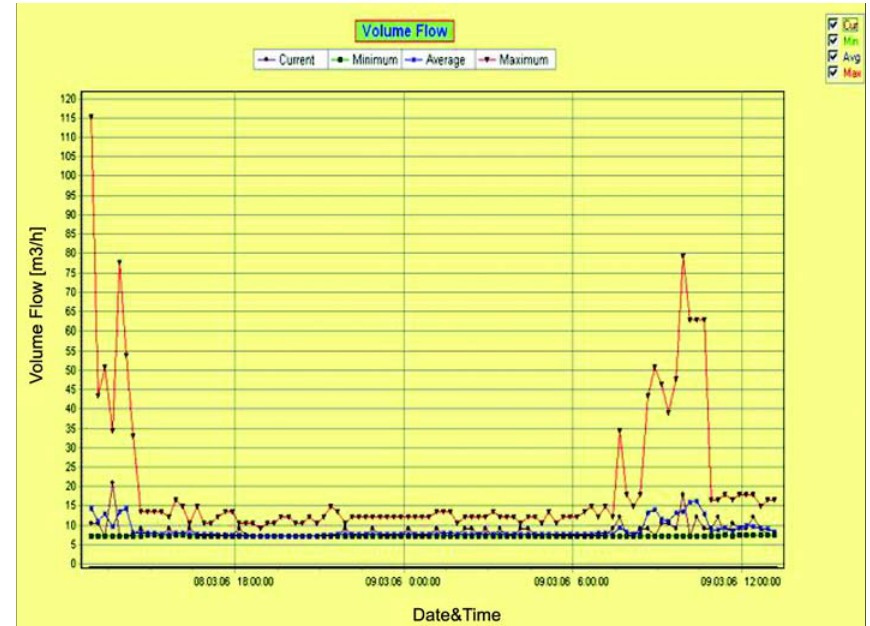
Fig 2. Volume flow